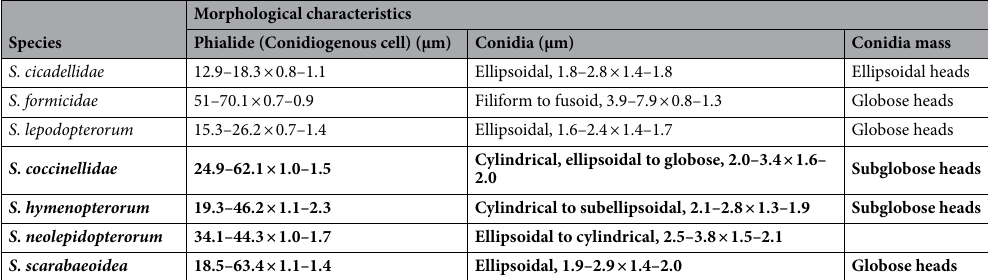
Table 1. Morphological comparison of four new species with other Simplicillium species.